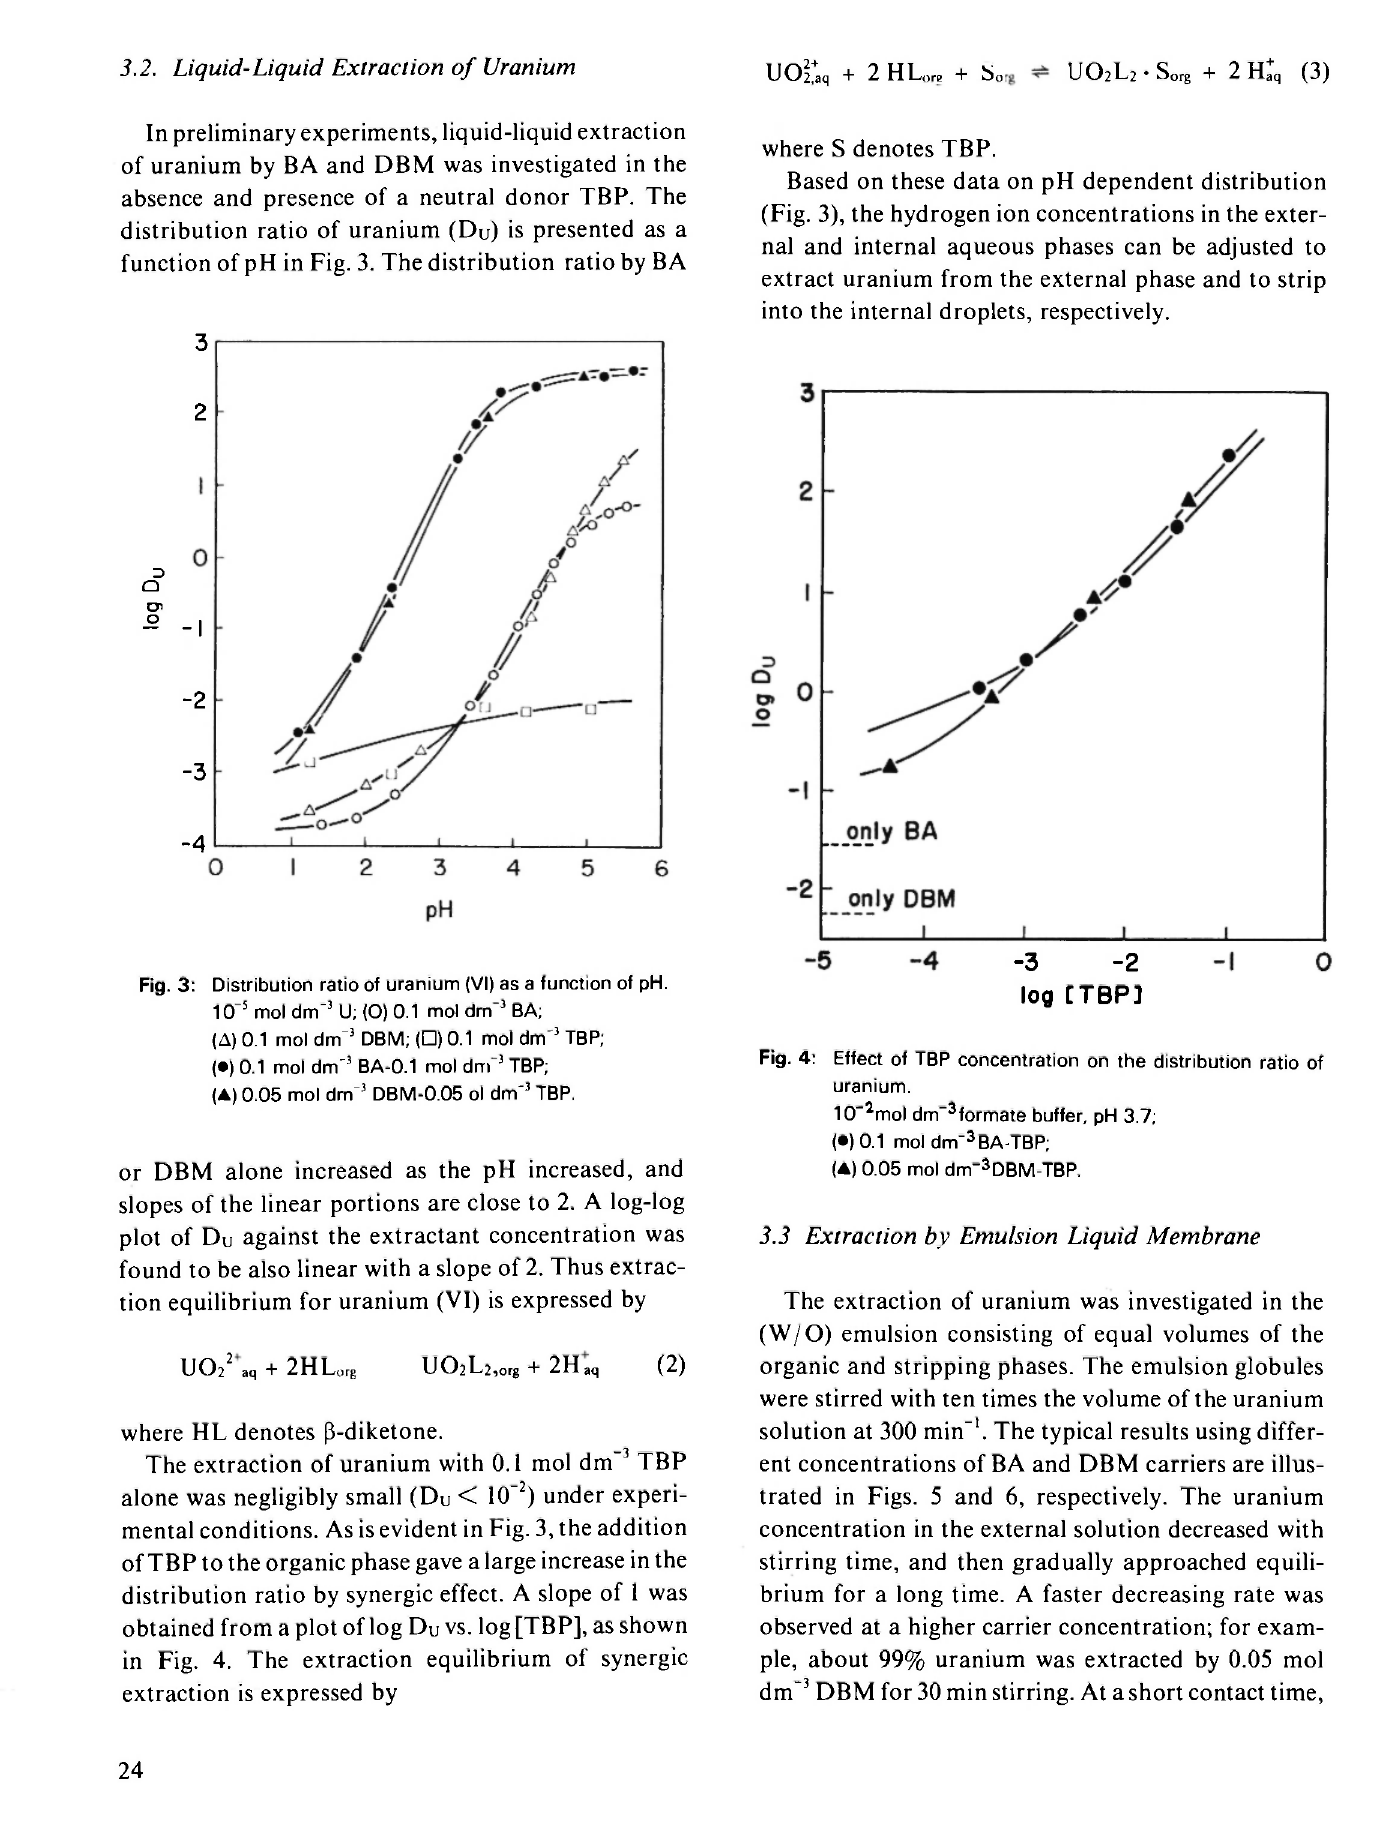
Fig. 3: Distribution ratio of uranium (VI) as a function of pH.